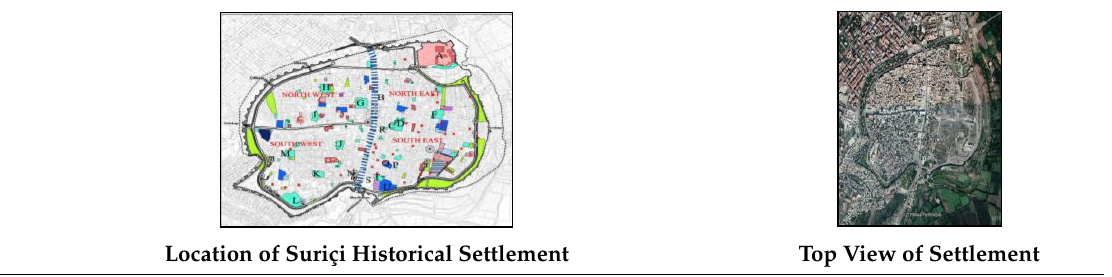
Table 1. Examples of space, street pattern in the historical settlement [21–27].